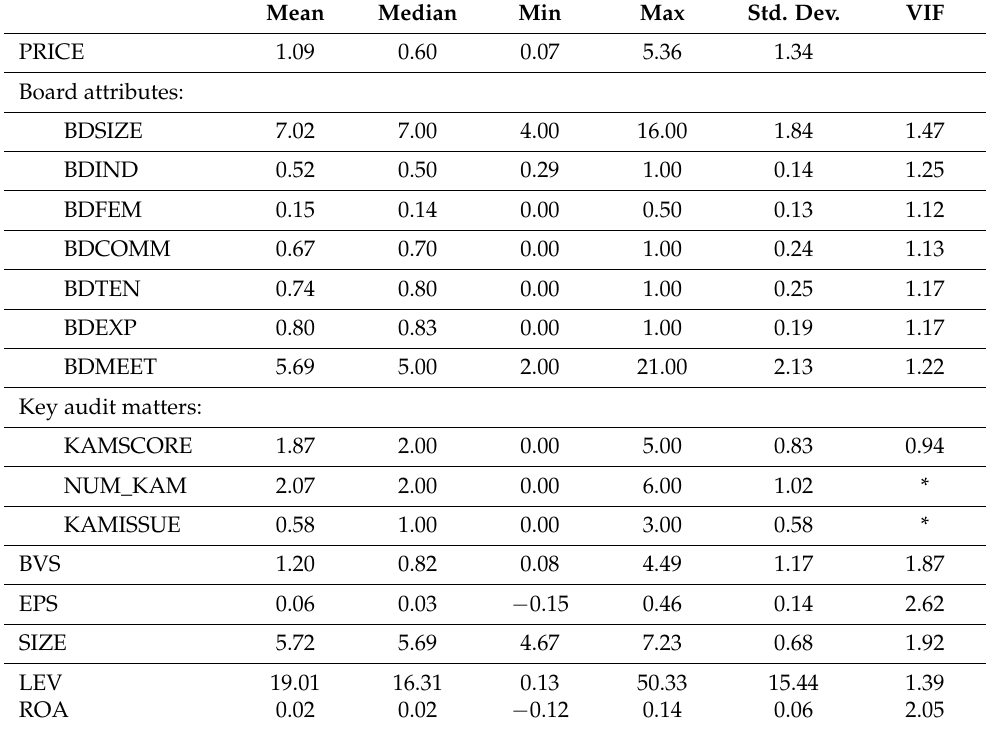
Table 3. Descriptive statistics of variables.